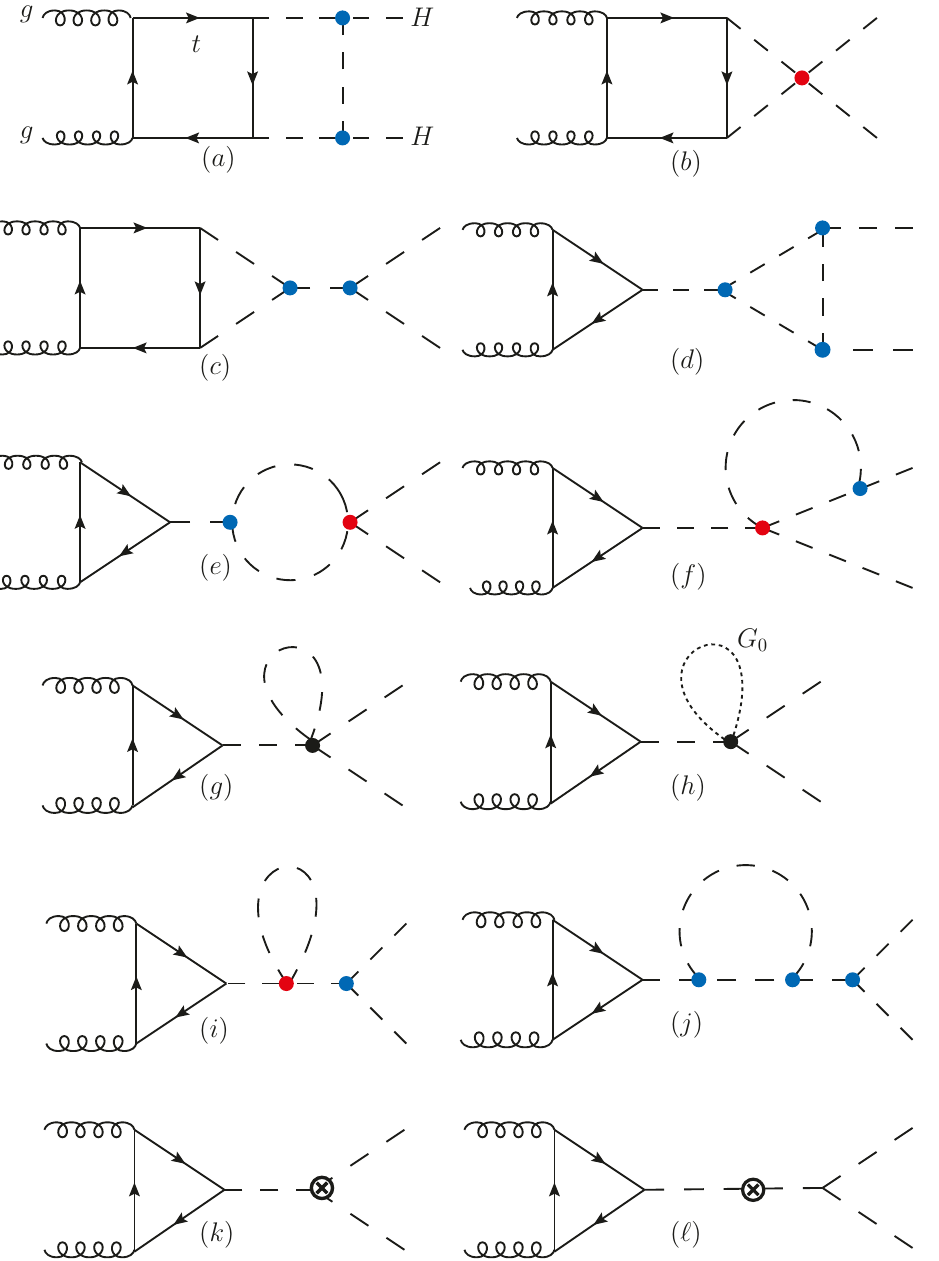
Figure 2 . Two-loop topologies involving (cid:22) c 6 and (cid:22) c 8 e(cid:11)ects on Higgs self coupling in gg ! HH . Except diagrams ( g ) and ( h ), all topologies are present in the SM. We have marked with a blob all the vertices involving (cid:22) c 6 and (cid:22) c 8 ; cubic vertices are in blue while quartic ones are in red. Diagrams ( a )- ( c ) are non-factorisable two-loop topologies. Diagrams ( d )-( h ), together with the counterterm ( k ), can be evaluated via the one-loop form factor V [ HHH ], while ( i ),( j ) and ( l ) with the P [ HH ] one.